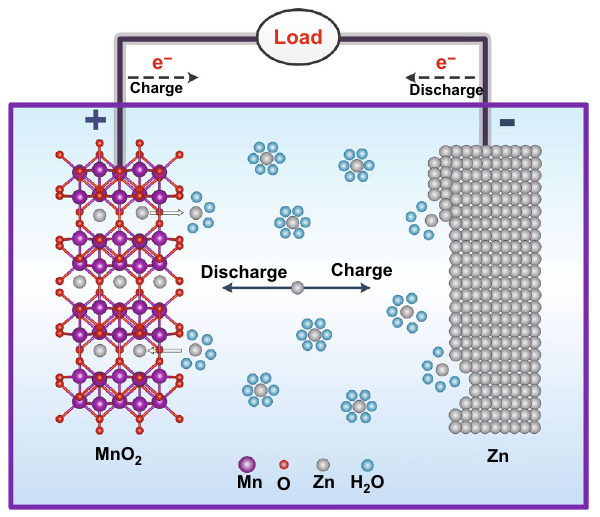
Fig. 1 Schematic diagram of the working mechanism of